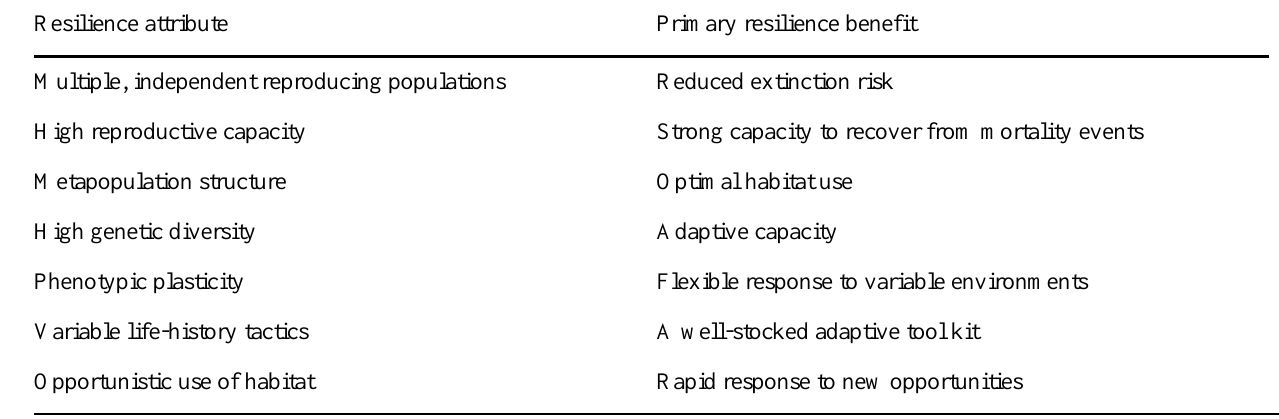
Table 1. Seven attributes of Pacific salmon species that contribute to their resilience, and a primary resilience benefit of each